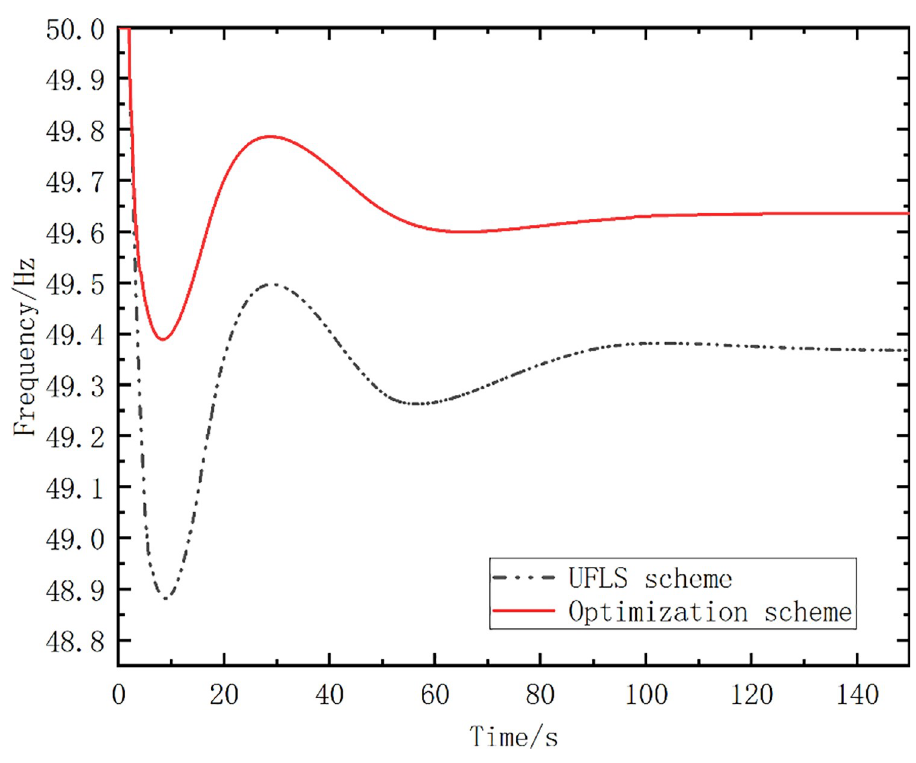
Fig 16. Simulated frequency curves (Case 2).